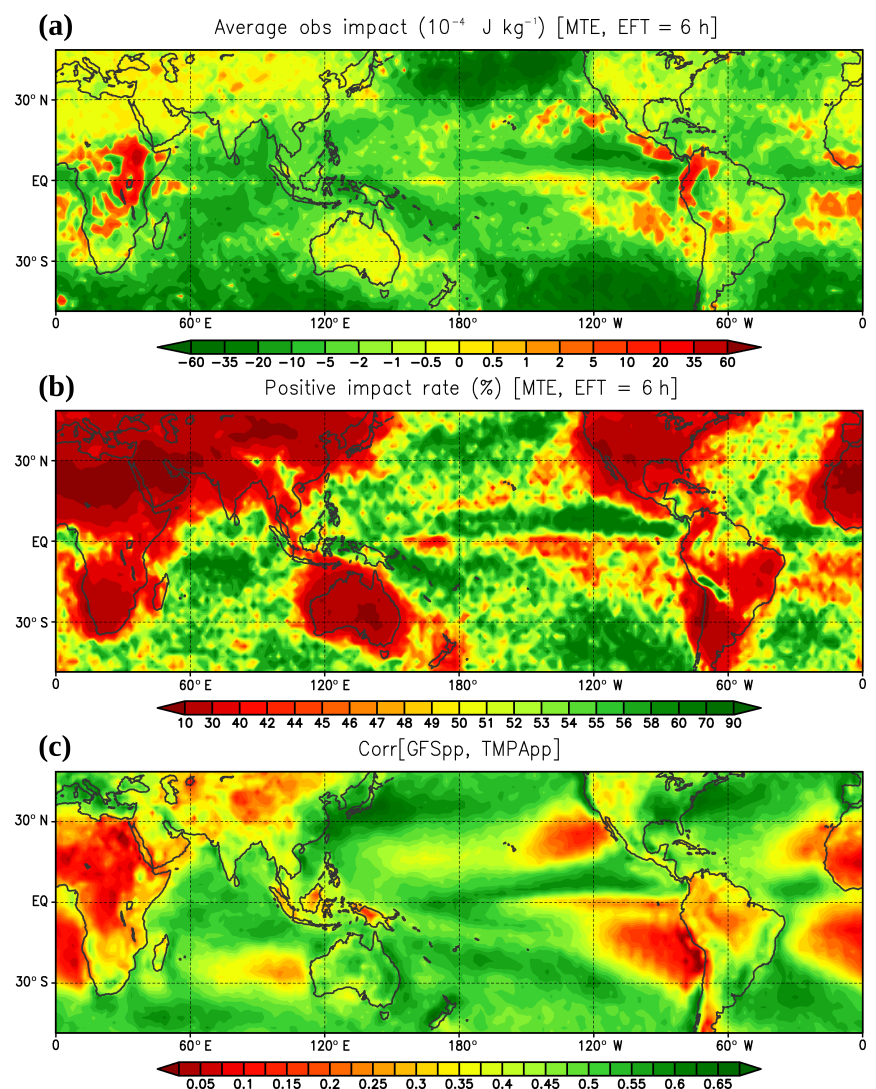
Figure 4. The maps of (a) the average per-obs EFSO (10 − 4 Jkg − 1 ) and (b) the rate (percent) of observations having positive impacts from the same precipitation EFSO sample (measured by the moist total energy norm) used in Fig. 2. (c) The maps of correlation between the 6h accumulated precipitation in the 3 to 9h T62 GFS model forecasts and the TMPA observations at the corresponding times during the 2001–2010 period. This correlation map is similar to Fig. 10 in Lien et al. (2016a), but for all seasons combined. Details on this correlation calculation are described in Lien et al.